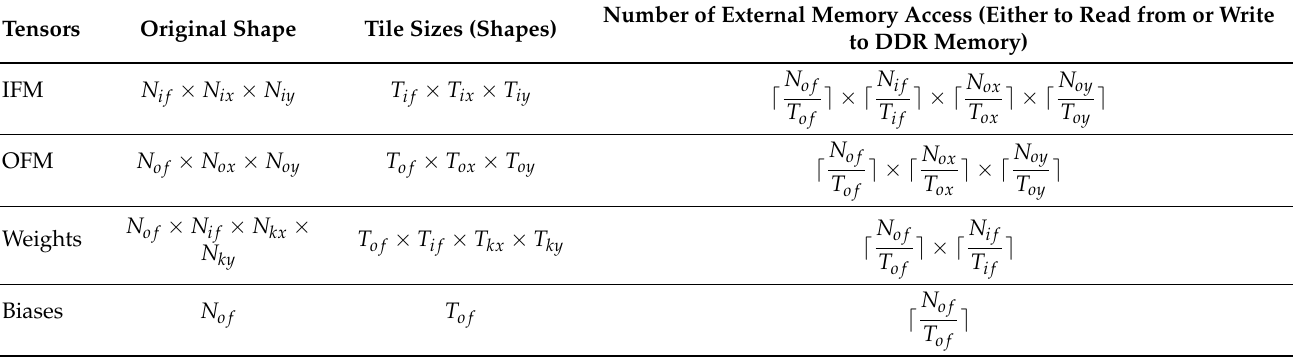
Table 2. Loop tile sizes and memory read–write access iterations to or from the tile buffers.